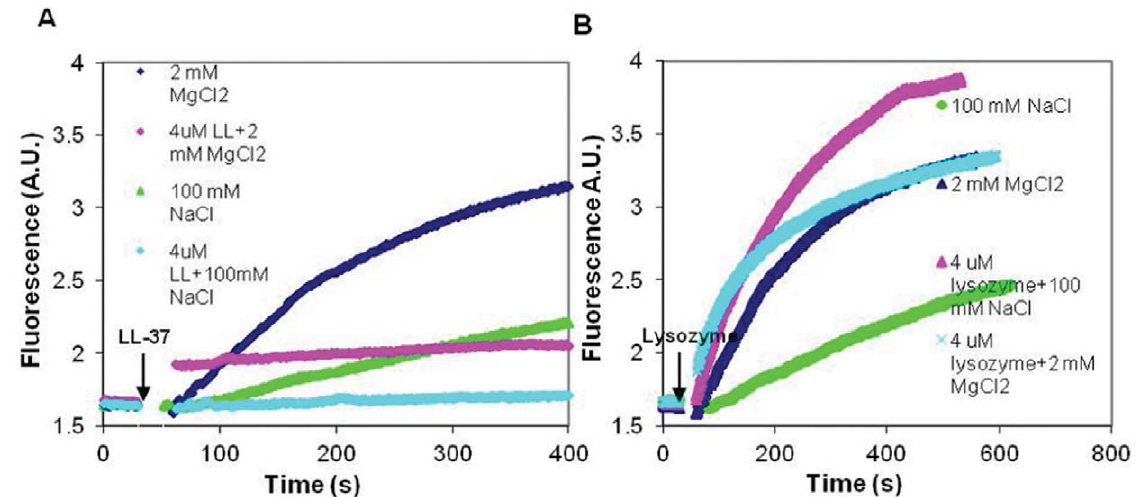
Figure. 2. Effect of LL-37and lysozyme, on the polymerization of MgATP-G-actin induced by 100 mM NaCl or 2 mM MgCl 2 . 4 m M LL- 37 (A) or lysozyme (B) were added (simultaneously with NaCl or MgCl 2 ) to pyrene labeled (10% labeling ratio) 2 m M MgATP-G-actin and the polymerization was followed by an increase in pyrene fluorescence. Presented data are representative of three independent experiments.